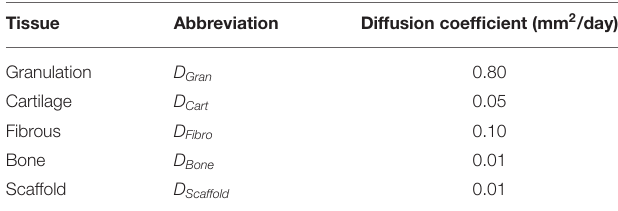
TABLE 4 | Diffusion coefficients of tissues (Kelly and Prendergast, 2005) and